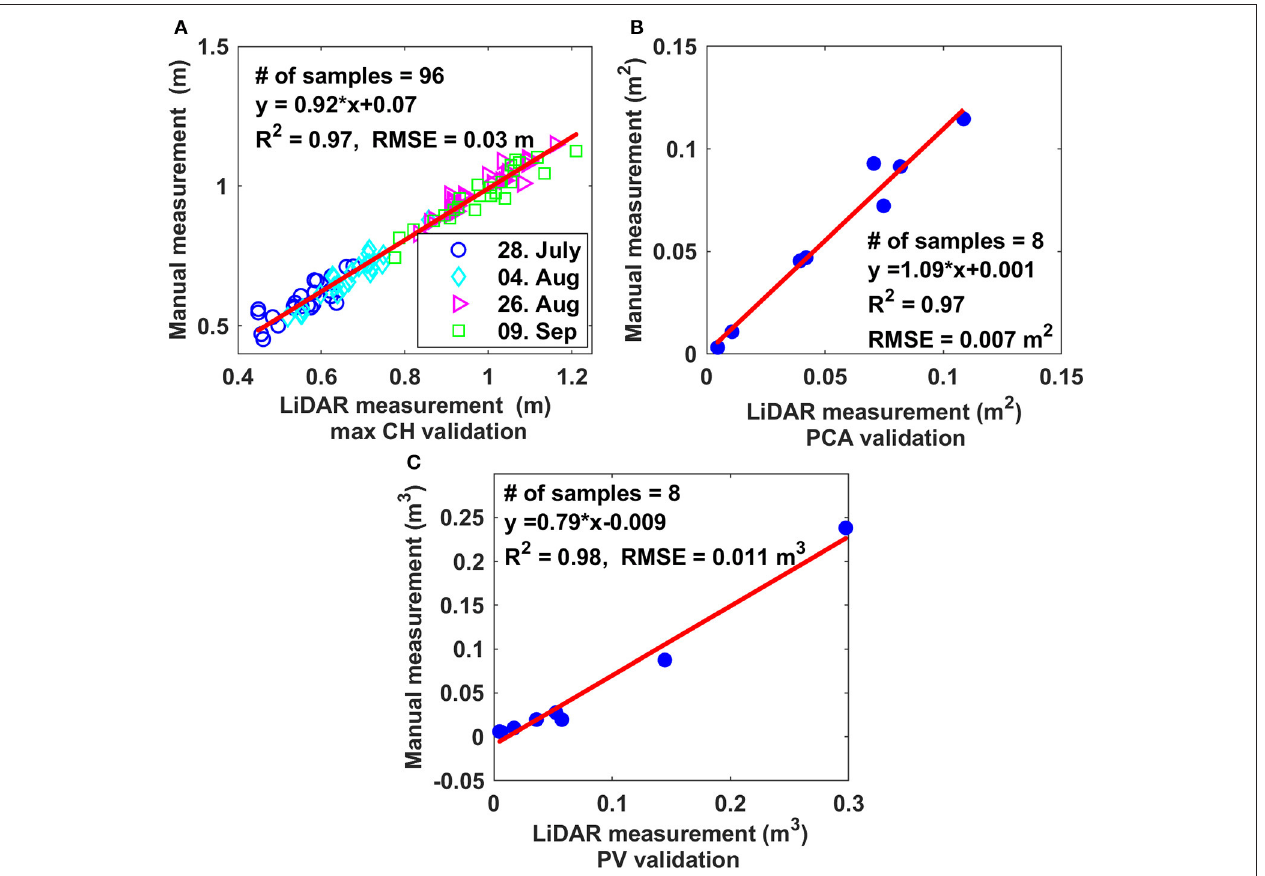
FIGURE 6 | Comparison of three derived morphologic traits based on LiDAR data with ground-truthing. (A) Maximum canopy height; (B) projected canopy area; (C) plant volume.